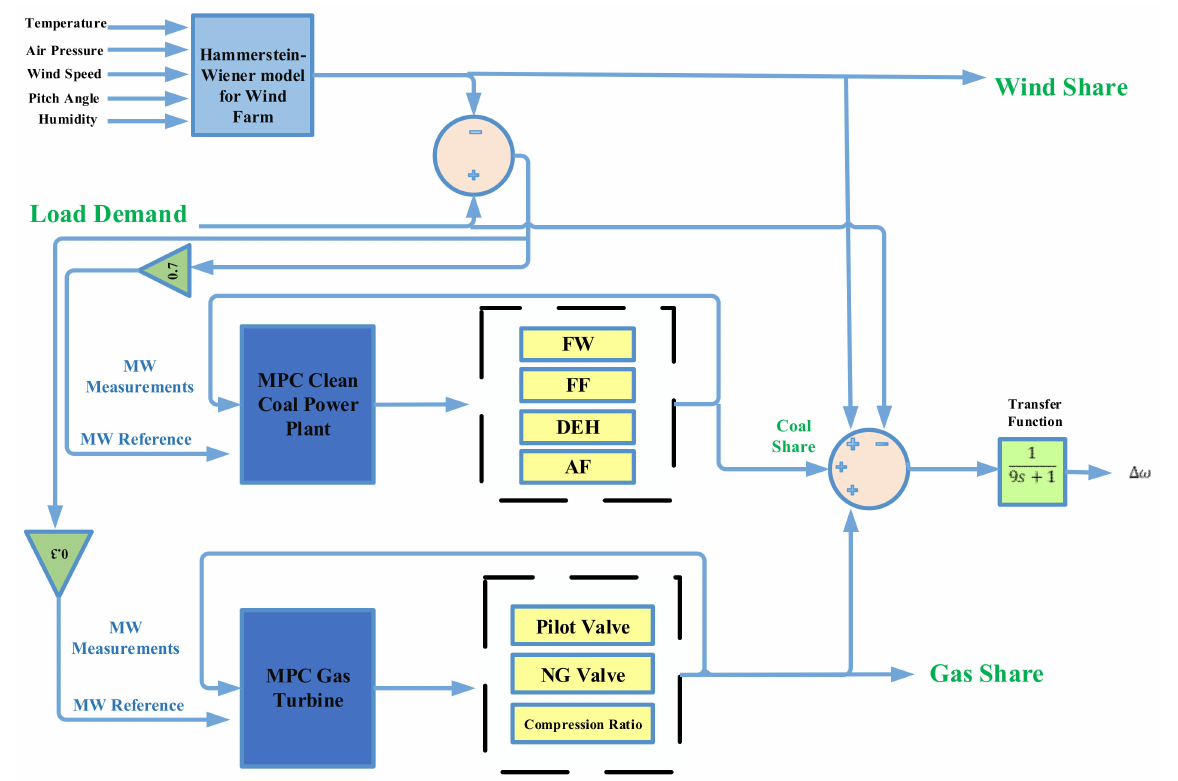
Figure 2. The proposed MPC-based LFC system for the multi-source power